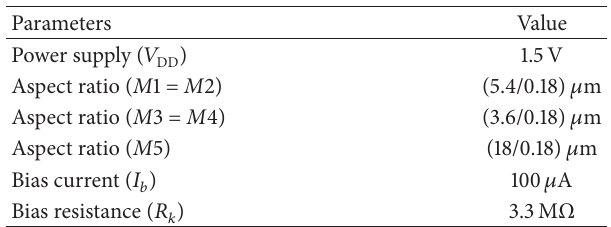
Figure 7: Proposed wideband high compliance current mirror. Table 1: Circuit parameters.